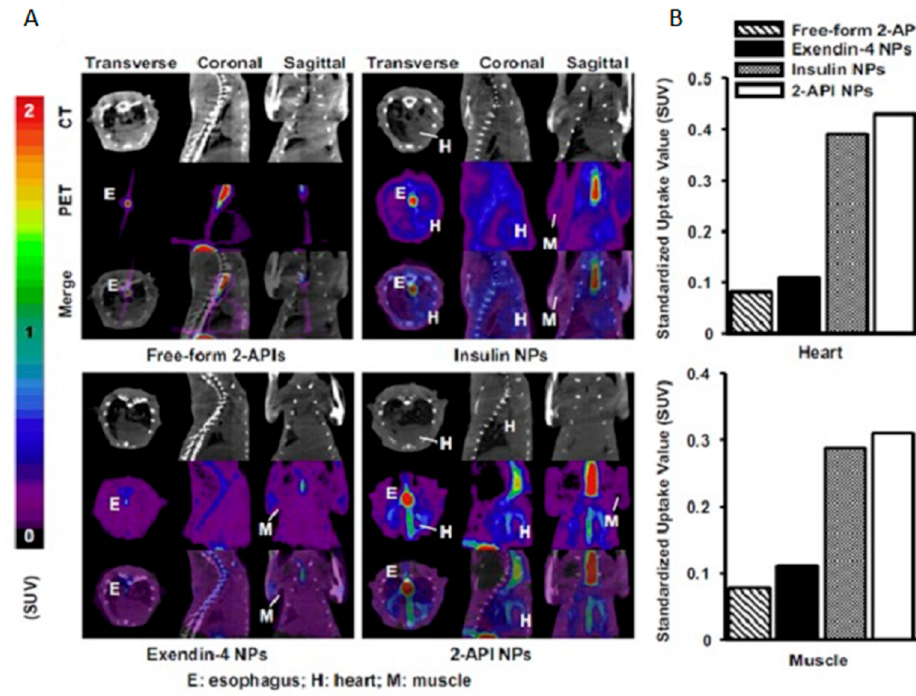
Figure 10. Oral biodistribution and utilization of 18 F-FDG was studied in type 2 diabetic rats using ( A ) PET/CT imaging and ( B ) standard uptake value (SUV) measurements in the heart and skeletal muscles. 2-API NPs are the combination nanoparticles of insulin and exendin-4. Reprinted with permission from Chuang et al. (2013) [126].